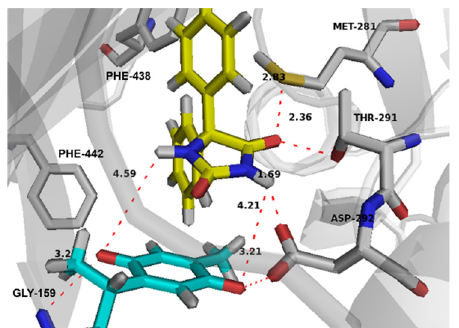
Figure 10. Binding interactions of co-bound PHT (carbons in yellow) and THQ (carbons in green) with the Akt active site. Distances are represented as red dotted lines and are measured in Angstrom. PHT and THQ indicate phenytoin and thymoquinone. Table 1. Dockings scores for PHT, THQ alone and co-bound in Akt and PI3K.